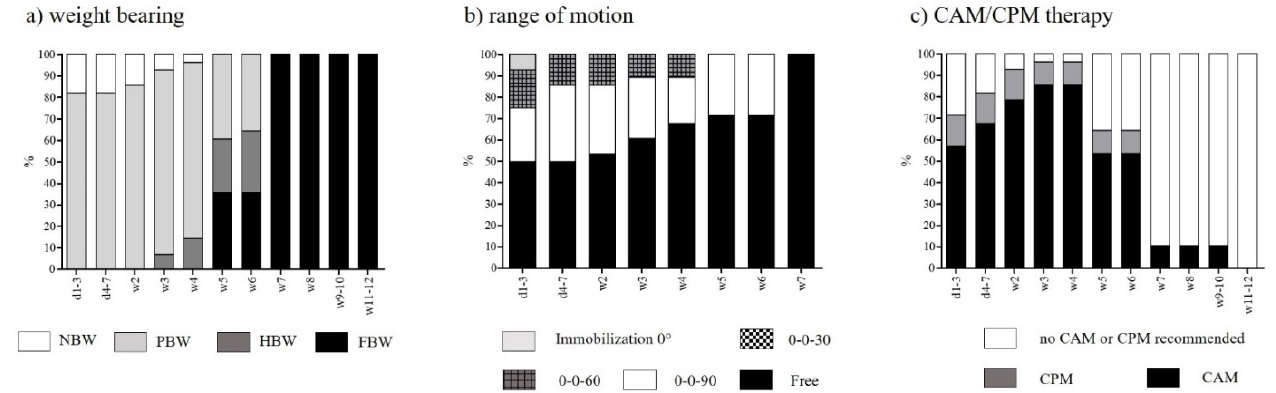
Figure 5. Early rehabilitation phase after femorotibial OATS concerning ( a ) weight-bearing, ( b ) range of motion, and ( c ) motion therapy, expressed as the percentage of protocols. NBW: no body weight; PBW: partial body weight; HBW: half body weight; FBW: full body weight; CAM: continuous active motion; CPM: continuous passive motion; d: day; w: week.